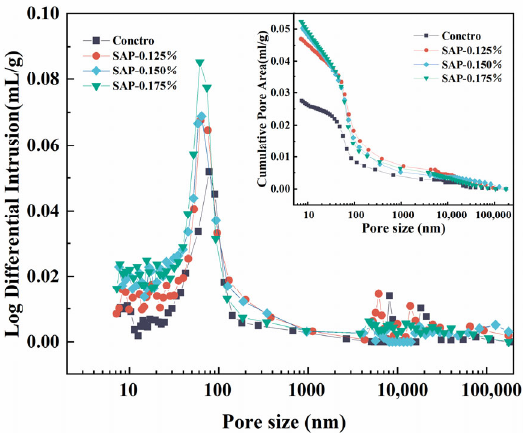
Figure 8. Fitting analysis of relative dynamic elastic modulus and damage degree.